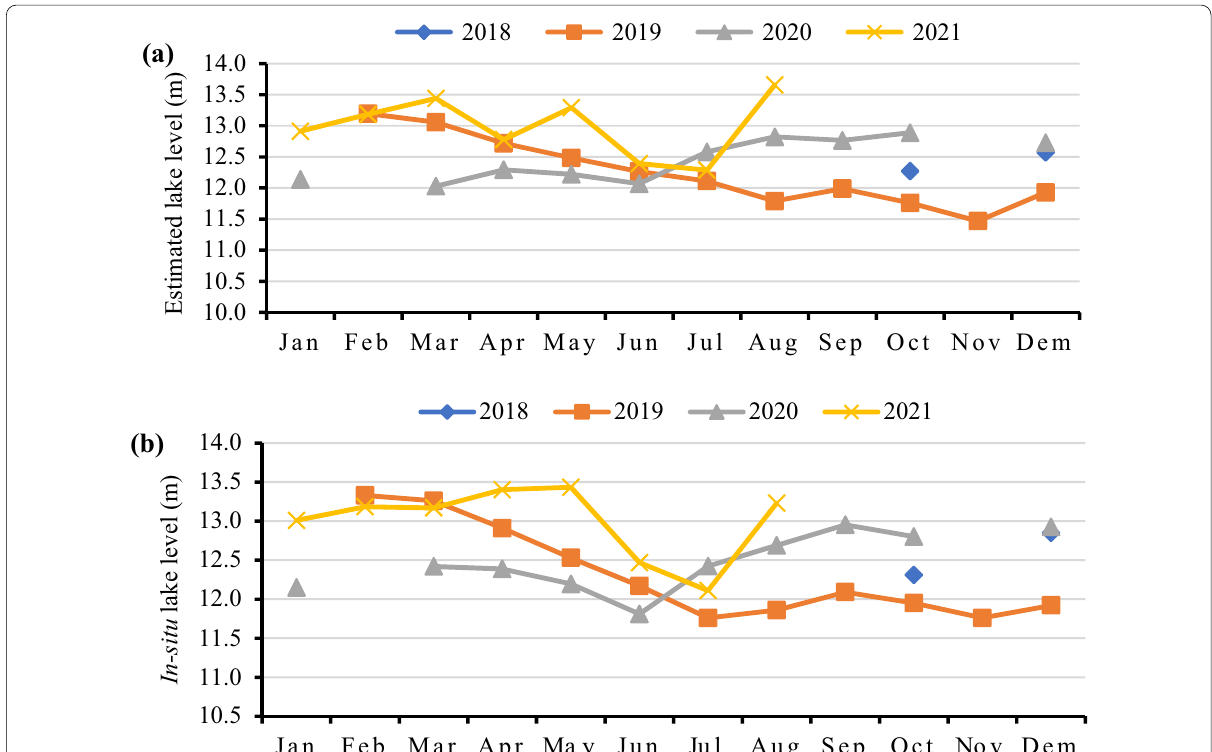
Fig. 7 Comparison of average water levels of each monthly and yearly variation of Hongze Lake: a estimated water levels; b in situ gauge water